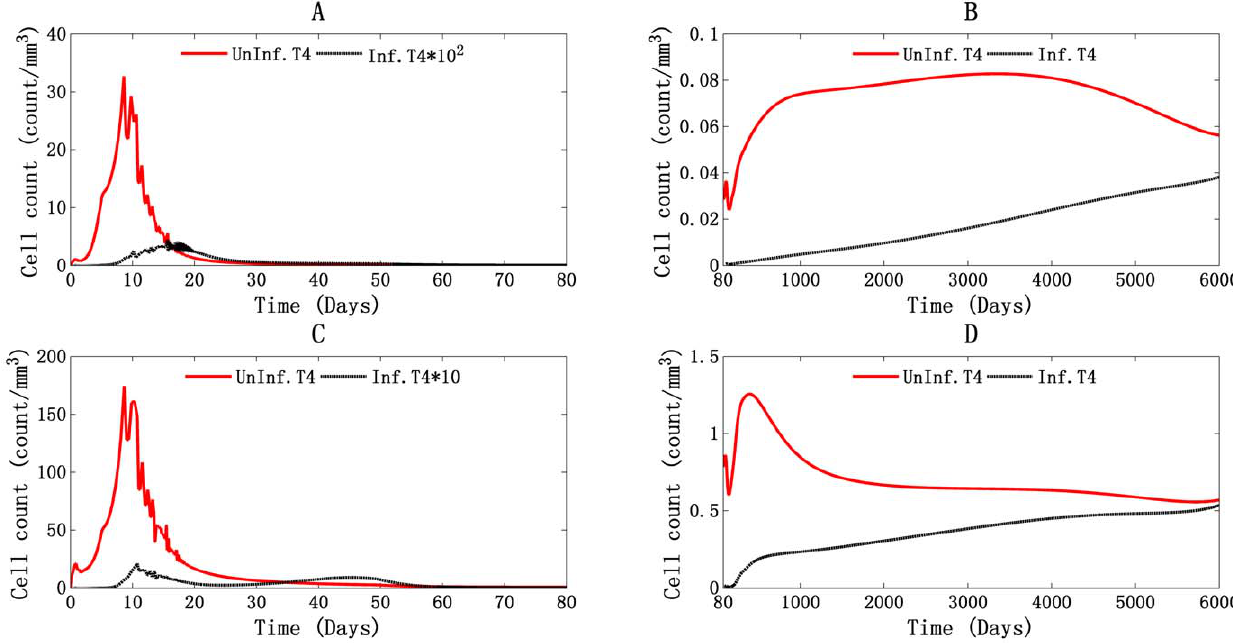
Figure 5. Daily death of T4 cells in PB and LNs. The daily death of infected and uninfected T4 cells in PB (A and B) and LNs (C and D), during the first 80 days (A and C) and from day 80 to day 6000 (B and D).